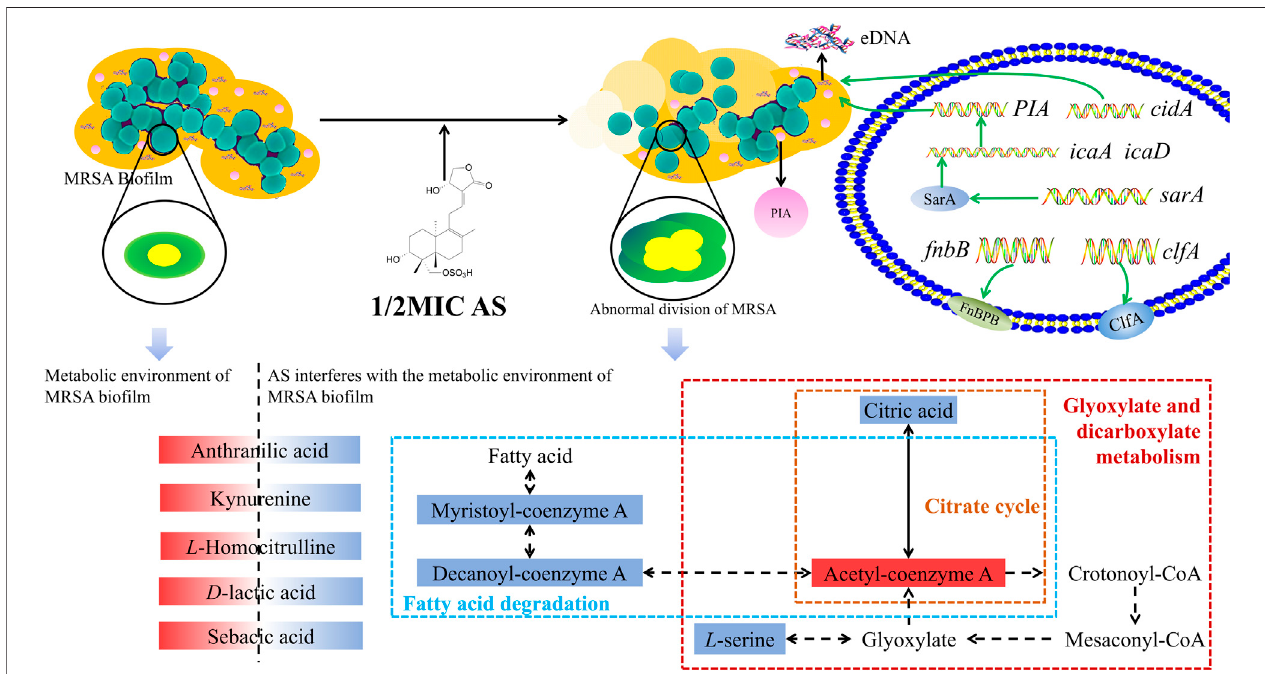
FIGURE 10 | Overview of the technical analyses described in the article. eDNA, extracellular DNA; PIA, polysaccharide intercellular adhesion; icaA , intercellular adhesion A; icaD , intercellular adhesion D; and FnbB, fi bronectin-binding protein B. The red solid box represents upregulated metabolite levels, and the blue box represents the downregulated levels. The blue dashed box represents the fatty acid degradation pathway, the yellow dashed box represents the citrate cycle pathway, and the red box represents glyoxylate and dicarboxylate